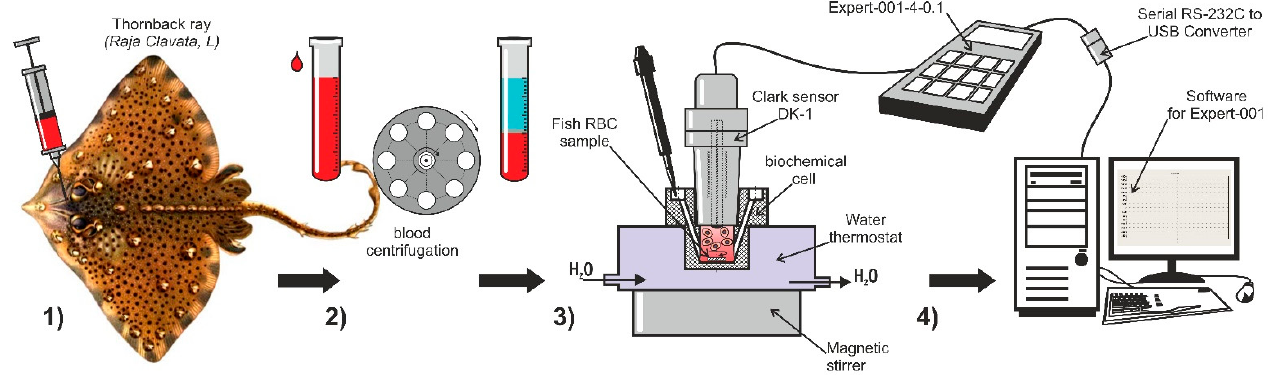
Figure 1. Scheme of the experiment for the respiration study of the thornback ray erythrocytes ( Raja clavata L.). ( 1 ) Taking blood from a stingray; ( 2 ) obtaining a suspension of erythrocytes by cen- trifugation; ( 3 ) polarographic cell with a Clark electrode for measuring the rate of oxygen utilization by skate erythrocytes; ( 4 ) recording part—polarograph “Expert-001 MTX” and